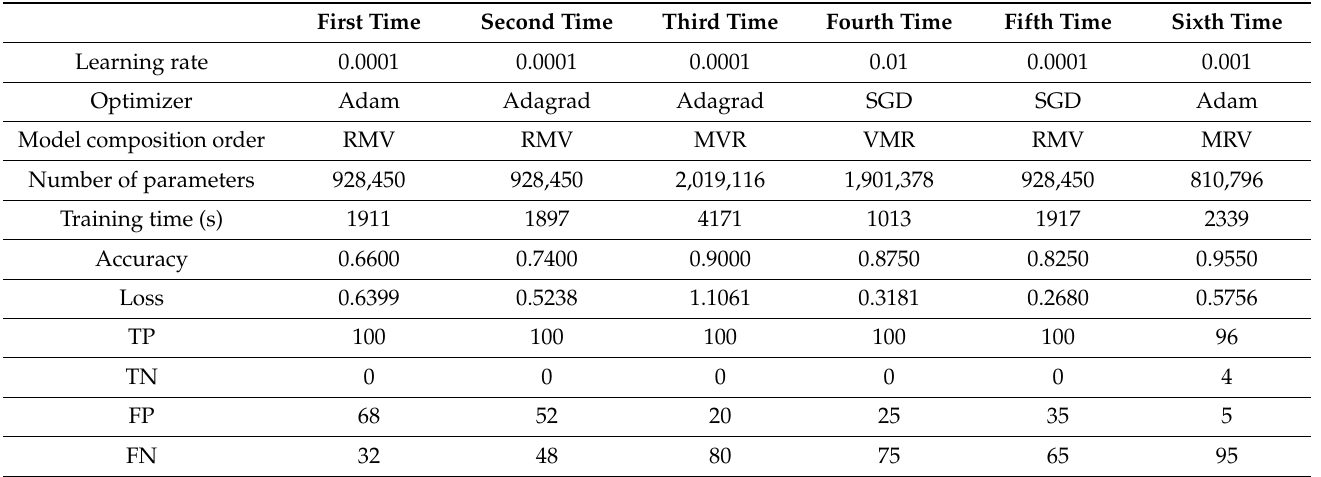
Table 6. Parameters and architectures selected by designed AutoML model in six training iterations.